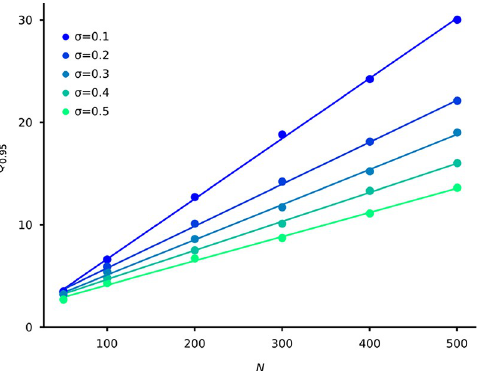
Fig 4. The memory capacity ( Q 0.95 ) as a function of the number of neurons ( N ) at different sparseness ( σ ). Similar to Fig 2, each point is an average of 400 realizations. The lines are the linear regression fits ( R 2 > 0.99 in all